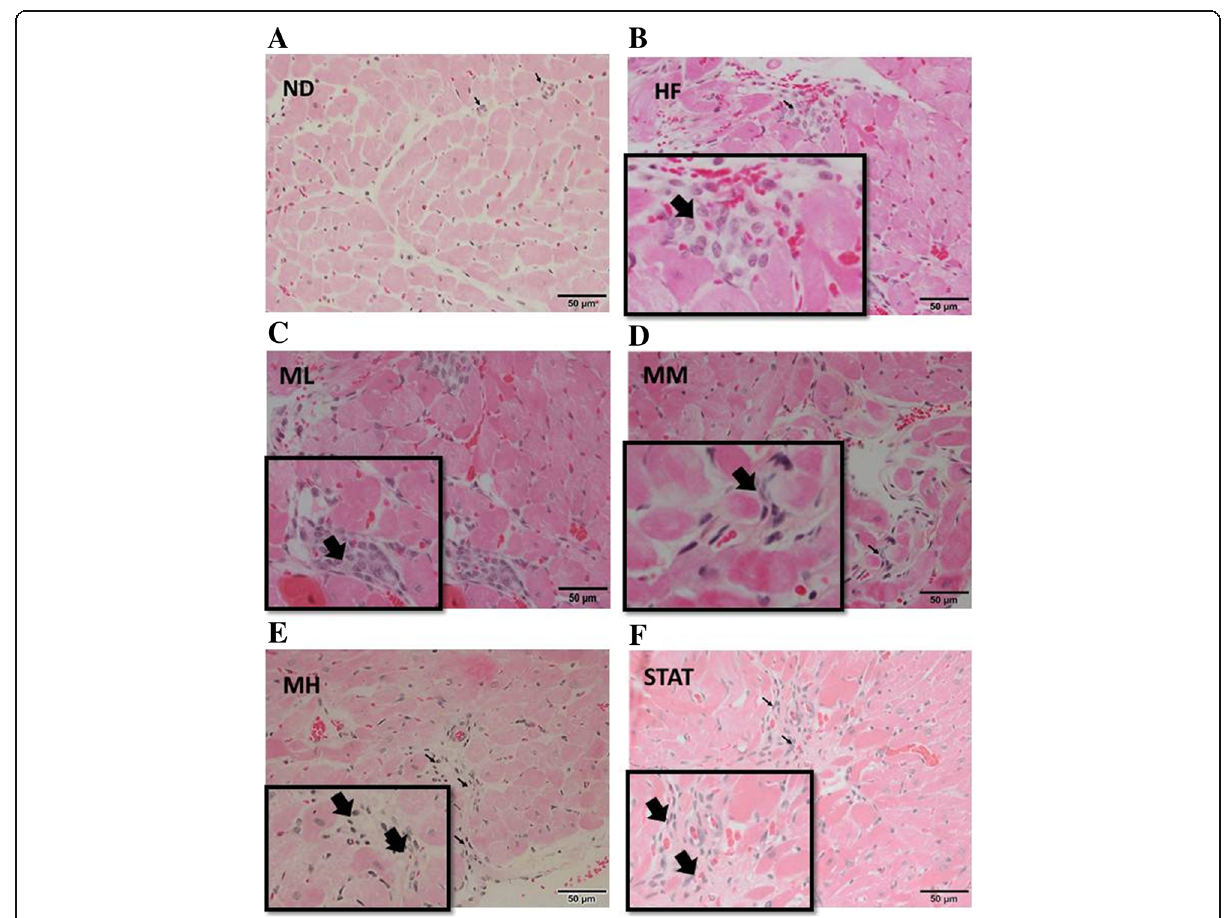
Fig. 3 Pathological changes in transverse-sections of cardiac tissues of rats after 12 weeks of treatment showing amounts of mononuclear cell infiltration in different treatments. a ND: a standard diet, b HF: a high-fat diet with distilled water, c ML, d MM and e MH: a high-fat diet with Maoberry extract at 0.38, 0.76 and 1.52 g/kg, respectively, f STAT: a high-fat diet with 10 mg/kg simvastatin. H&E staining (magnification× 100). Arrows represent mononuclear cell infiltration. Panels enlarge the area of pathological alterations (magnifiacation ×